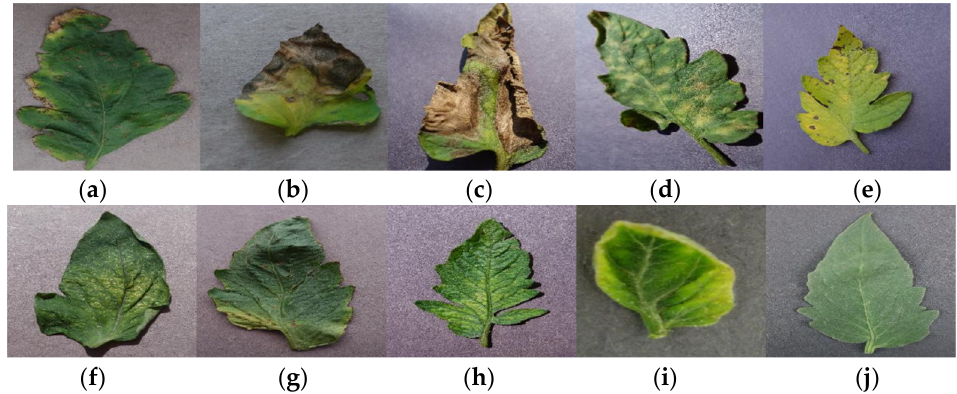
Figure 1. Sample leaf image with disease and pathogen for ( a ) Bacterial_Spot(Xanthomonas vesica- toria), ( b ) Early_Blight(fungus Alternaria solani), ( c ) Late_Blight( Phytophthora infestans ), ( d